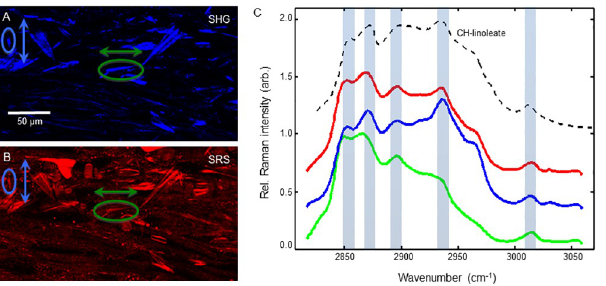
Fig 8. Hyperspectral scan of HIV + plaque needle CCs detect a CE dominate signature. Left panels show the SHG (A, top) and SRS (B, bottom) with two object regions denoted (green and blue ovals with arrows indicating relative polarization direction). Graphed right (C) are the spectral traces of the individual objects (green and blue lines), their average (red), with the top black dashed trace showing the cholesteryl linoleate reference SRS spectrum.